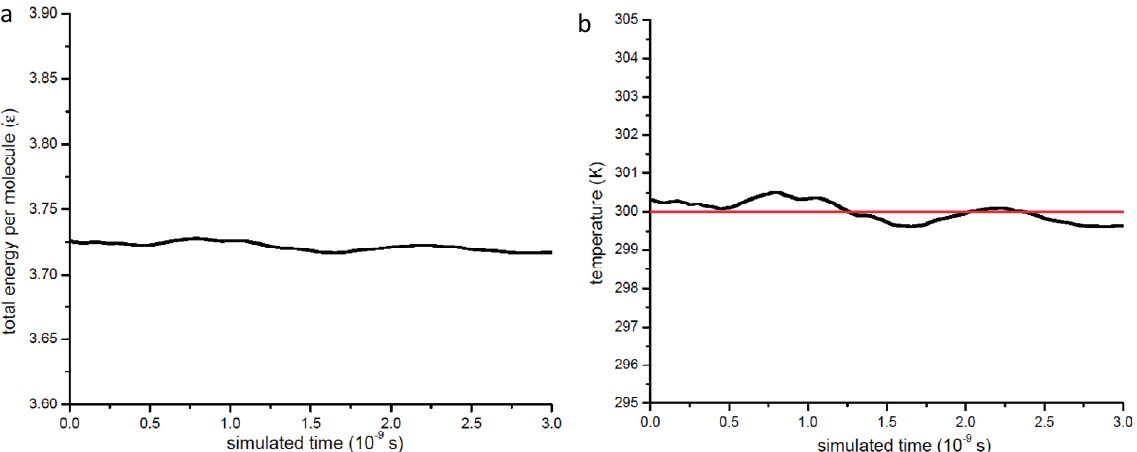
Figure 11. Thermal property’s variation with the simulation time for the case